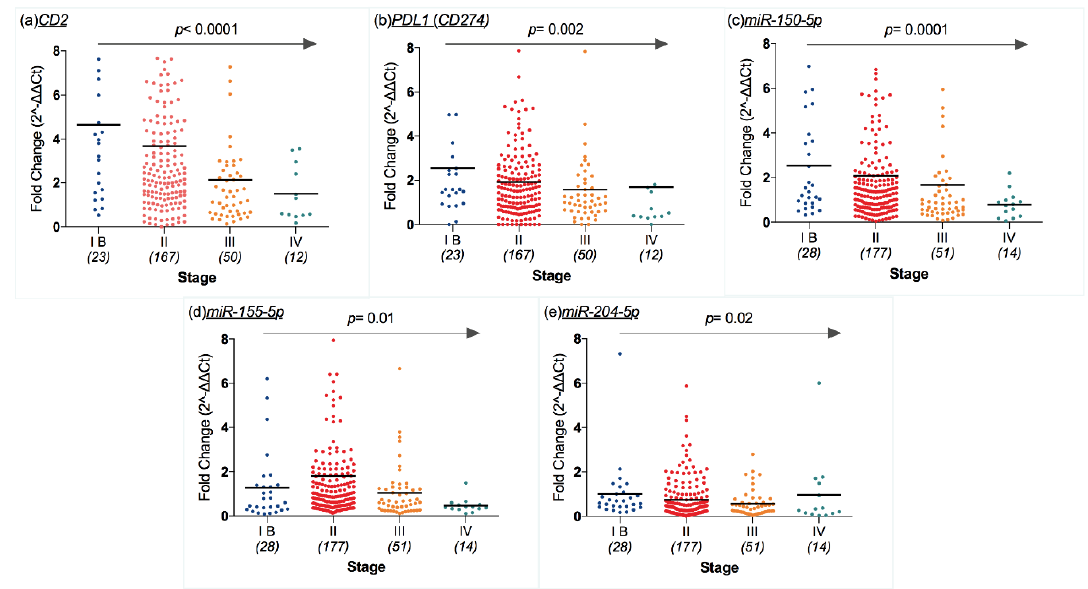
Figure 3. Scatter dot plots representing mRNA and miRNA expression levels (ratio of threshold cycles) that were different according to cutaneous melanoma’s (CM) stage: ( a ) CD2, ( b ) CD274, ( c ) miR-150-5p, ( d ) and miR-155-5p, and ( e ) miR-204-5p decreased as stage progressed ( p < 0.0001, p = 0.002, p = 0.0001, p = 0.01 and p = 0.02). Middle lines refer to the median value ( p values on the graph refer to Spearman’s rank correlation test using CM stage as the ranking variable).